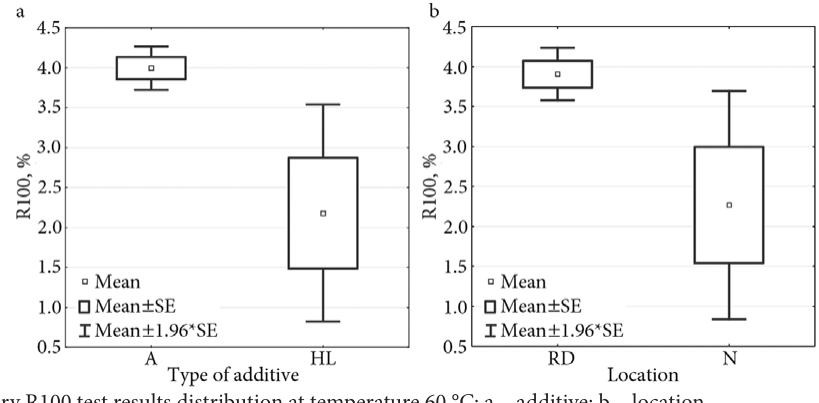
Fig. 12. Elastic recovery R100 test results distribution at temperature 60 °C: a – additive; b – location